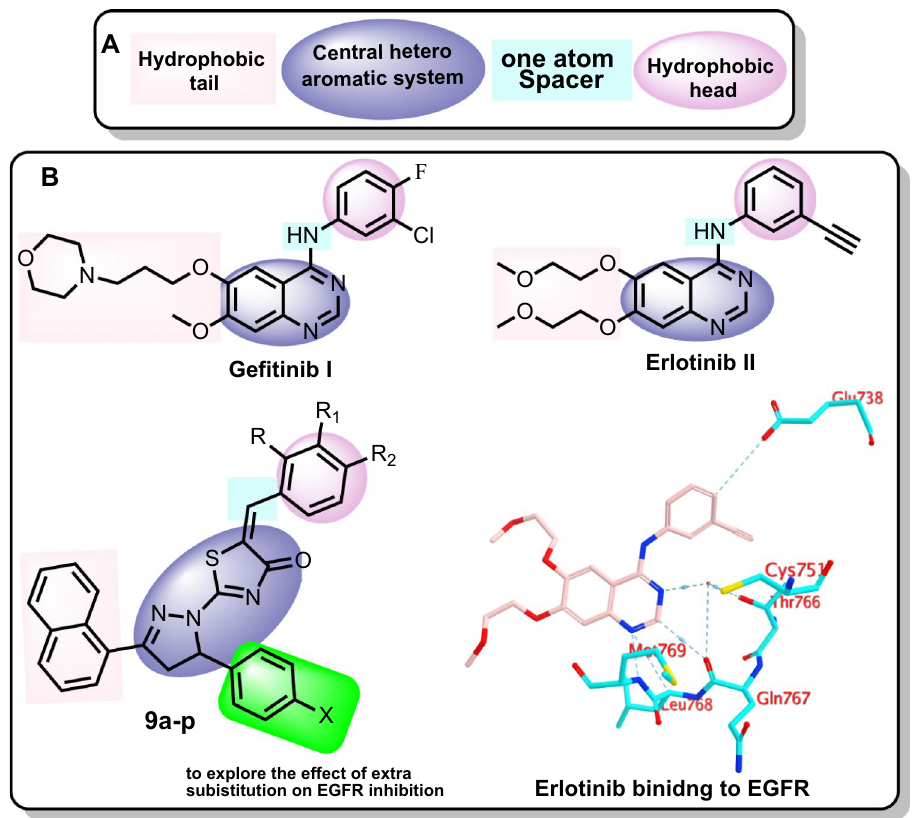
Figure 1. ( A ) The reported pharmacophoric features of EGFRIs. ( B ) Reported FDA EGFR inhibitors (Gefitinib and Erlotinib) and the synthesized compounds in this study ( 9a-p ), as well as the binding mode of Erlotinib within EGFR active